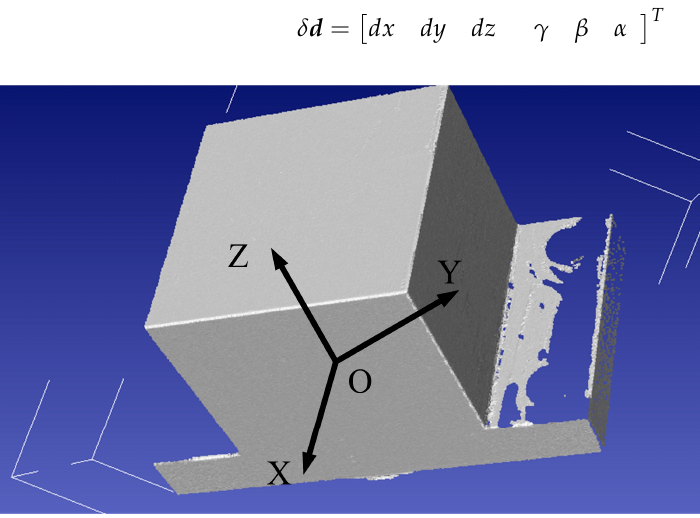
Figure 8. The target block at the end of the robot.